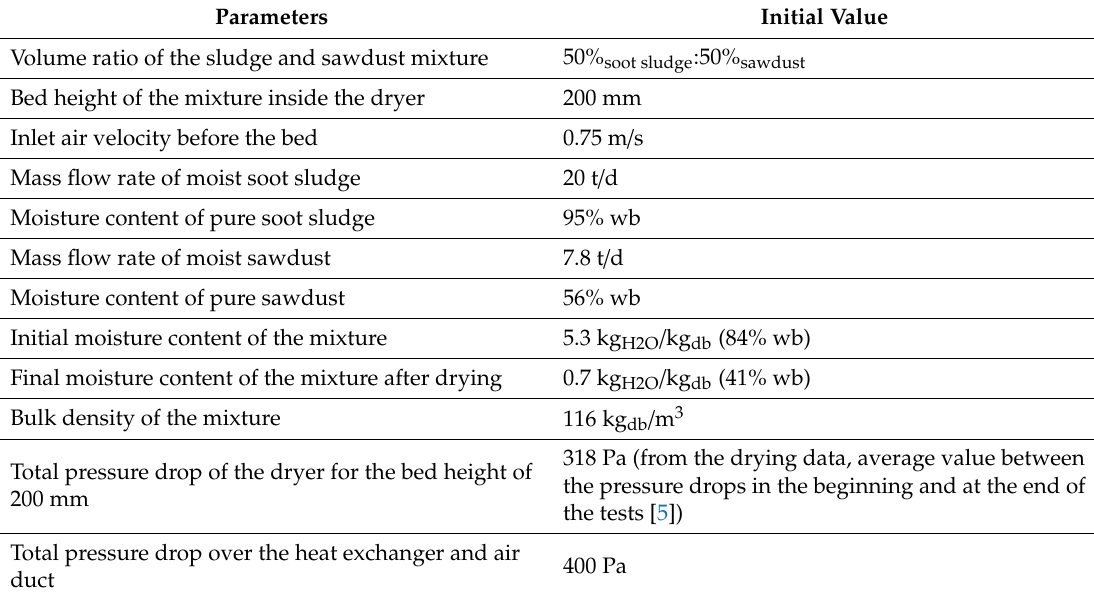
Table 5. The initial values for the economic